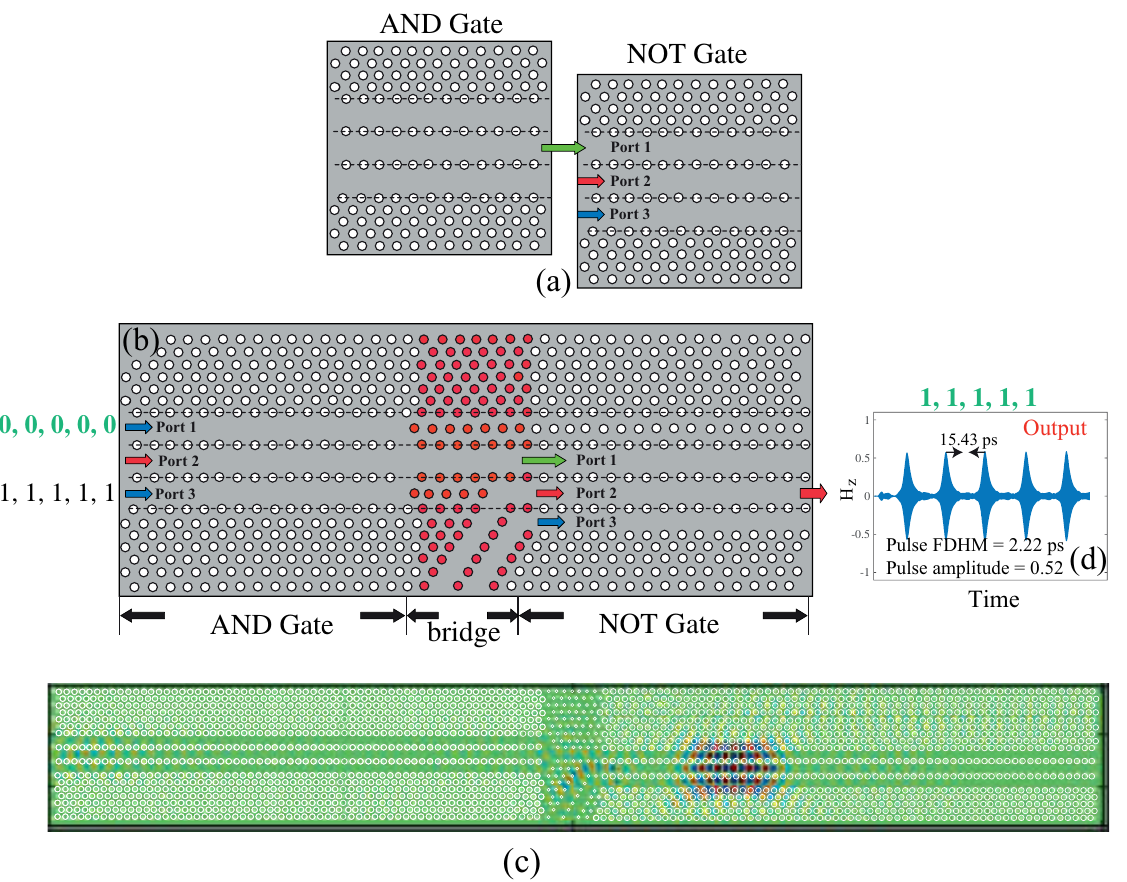
Figure 7. ( a ) Schematic visualization of NAND logic gate as a series connection of the AND and the NOT logic gate; ( b ) NAND logic gate on a single enlarged chip; ( c ) magnetic field profile of the gap soliton pulse in the NAND logic gate; ( d ) output magnetic field H z from the Port 2 after injection “0” and “1” input signals into the Ports 1 and 3, respectively. Reprinted from Ref.